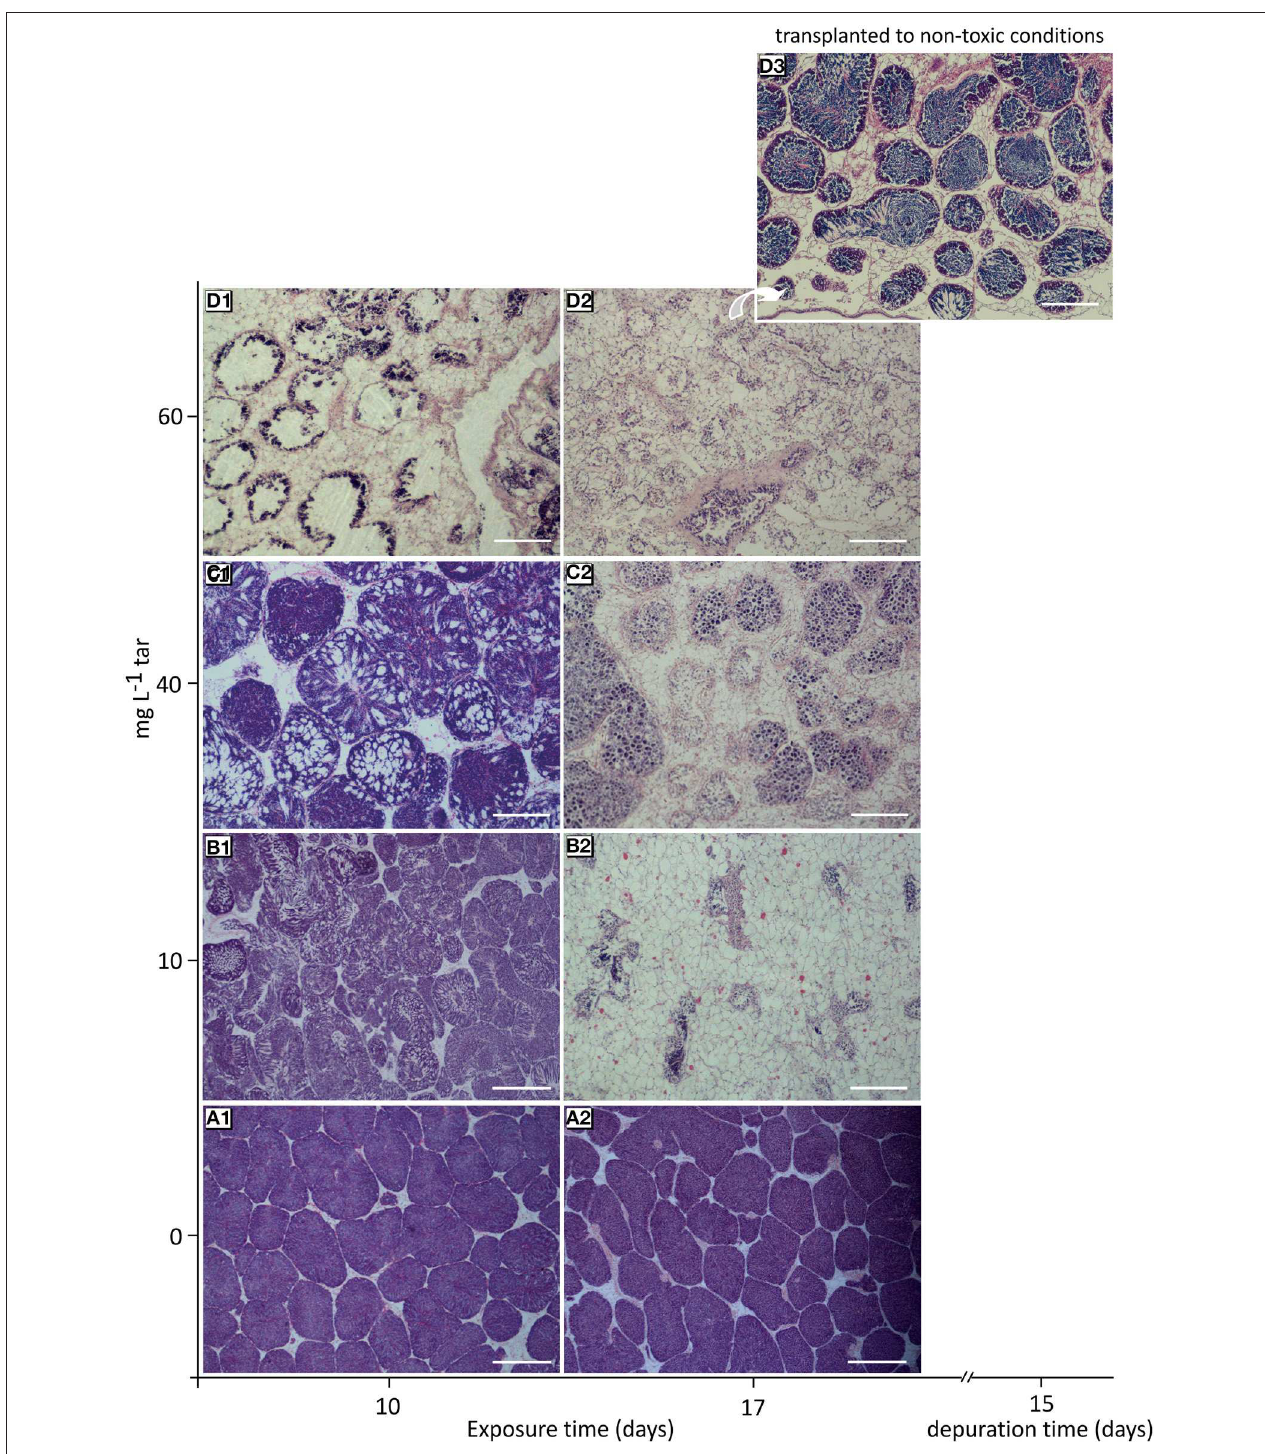
FIGURE 2 | Histological overview of the gonad from mussels exposed to different tar concentrations for 10 and 17 days. (A1,A2) Reference mussels (0 mg L − 1 tar) showing a typical pre-spawn stage. (B1) Spawn induction. (B2) Atrophy of gonadal follicles in mussels exposed to 10 mg L − 1 tar. (C1) Sloughing of spermatids. (C2) Loss of radial architecture of germinal epithelium and hyalinisation of basement membrane of follicles in mussels exposed to 40 mg L − 1 tar. (D1) Disappearance of advanced germ cells. (D2) Virtually empty gonadal follicles with hyperchromatic spermatocytes and proliferation of storage tissue cells in mussels exposed to 60 and 80 mg L − 1 tar. (D3) Gametogenesis reactivation in mussels transplanted to non-toxic conditions for 17 days after exposition to 60 mg L − 1 tar. Haematoxylin and eosin stain. Scale bar: 500 mm (A1,B1) , 200 mm (B2–D3) .